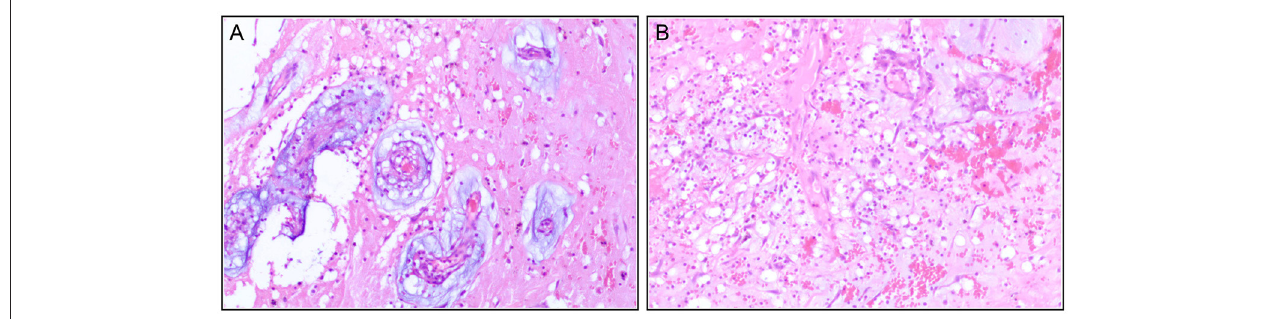
FIGURE 4 | Immunohistochemistry post-operatively confirm the diagnosis of the cardiac myxoma with interstitial fibrous hyperplasia (A) , hemorrhage (B) , necrosis, and plasmacytes